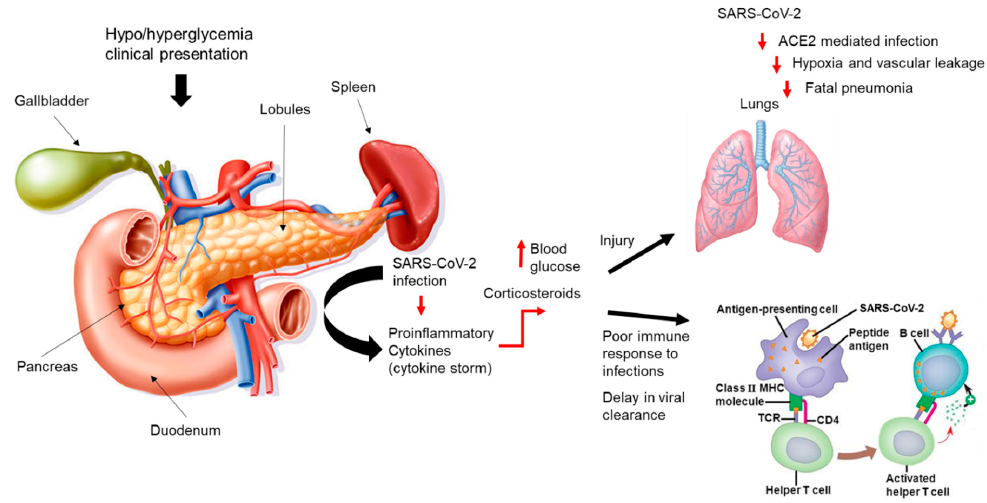
Figure 1. Diabetes and increased risk for severe coronavirus disease 2019 (COVID-19).